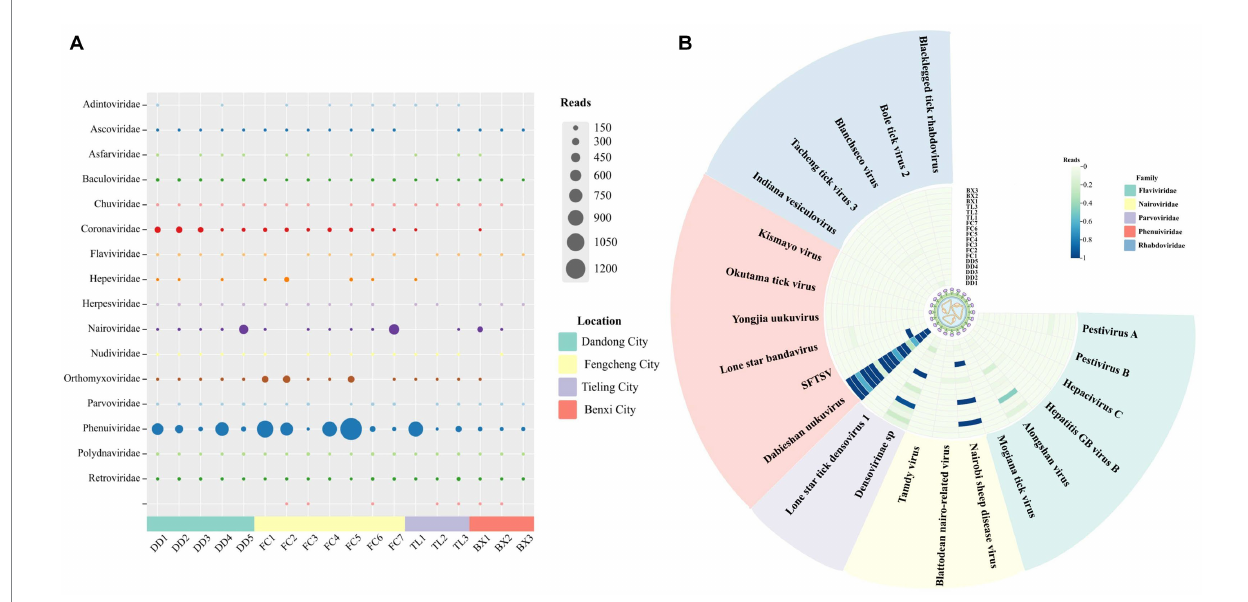
FIGURE 6 Viral presence and abundance across the pools. (A) The abundance of viral family reads in each pool. (B) The distribution of reads of tick-associated viruses in each pool.